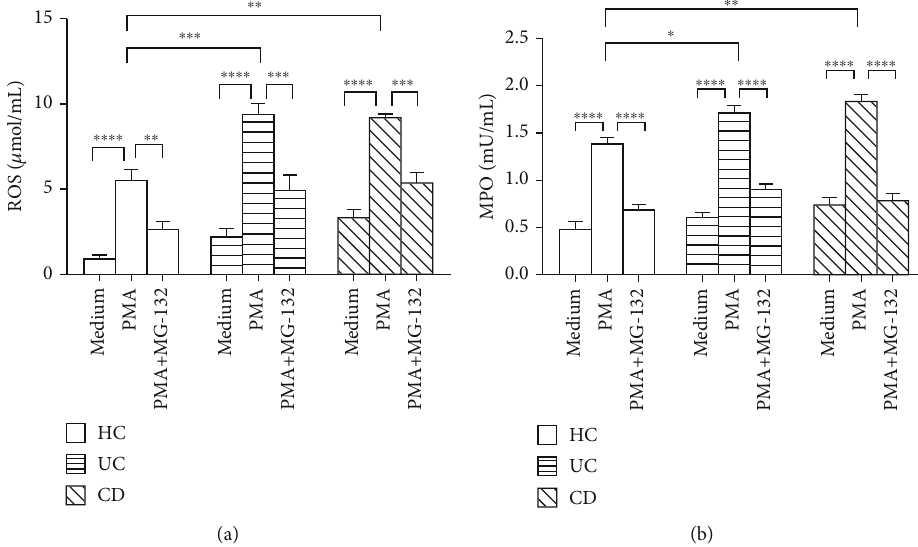
Figure 3: MCPIP-1 downregulates the production of ROS and MPO. Peripheral neutrophils ( 1 × 10 5 ) were isolated from patients with active CD ( n = 10 ), active UC ( n = 10 ), and HC ( n = 10 ) and stimulated in vitro with PMA (100ng/mL) in the absence or presence of MG-132 (20 μ M) for 3 hours. The levels of ROS (a) and MPO (b) were measured by an Amplex Red Hydrogen Peroxide Assay Kit according to the manufacturer ’ s instructions. ∗ P < 0 : 05 , ∗∗ P < 0 : 01 , ∗∗∗ P < 0 : 001 , and ∗∗∗∗ P < 0 : 0001